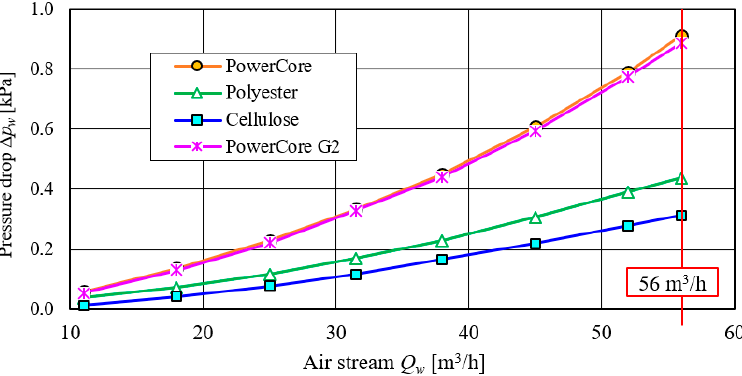
Figure 15. Flow characteristics, Δ p w = f ( Q w ), of filter media before testing with test dust.